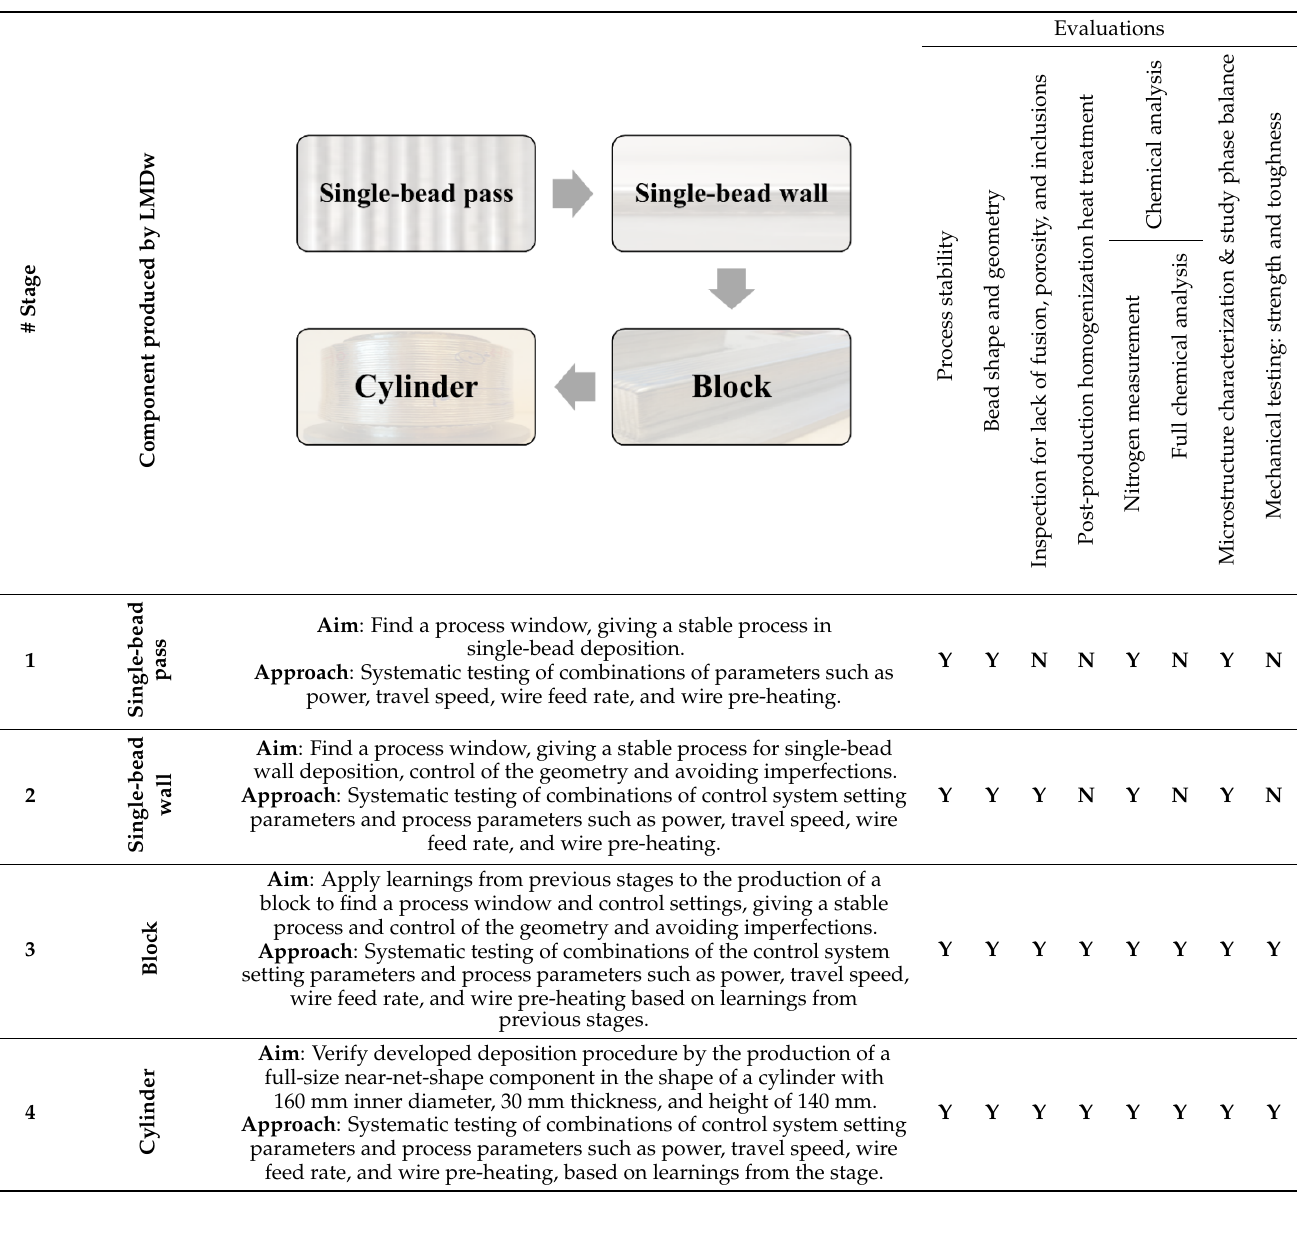
Figure 1. The four-stage methodology applied to the production of a DSS near-net-shape component by LMDw. Table 1. Aim, approach, and testing strategy of each stage in the four-stage methodology. Y (YES) = test was performed, N (NO) = test was not performed.